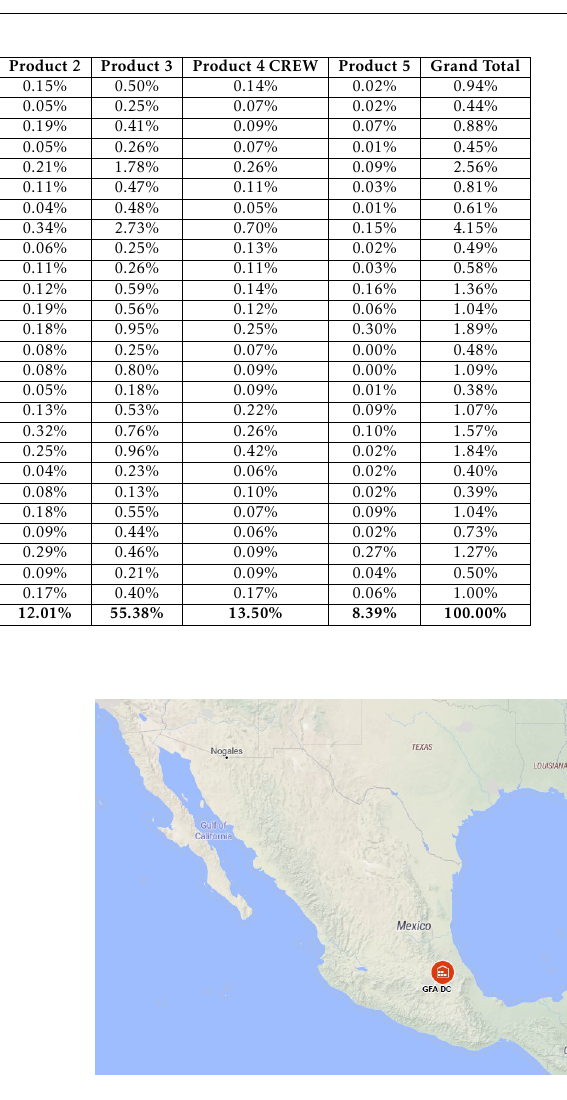
Figure 6. New distribution center location